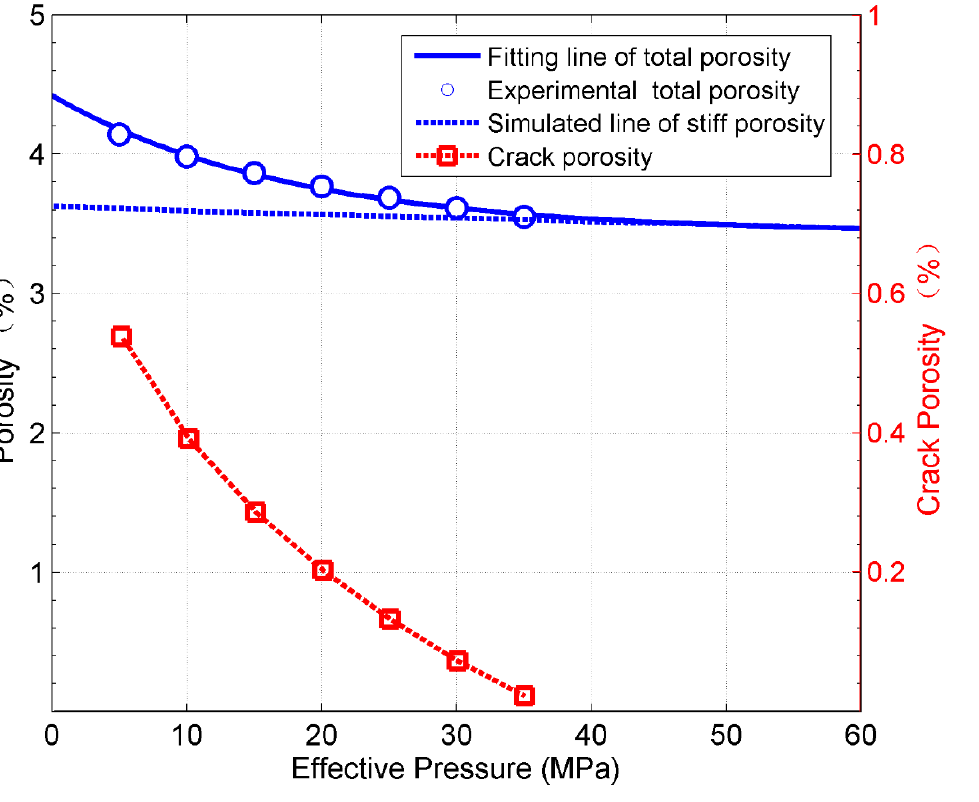
Figure 9. Total, stiff, and microcrack porosities as a function of the effective pressure.